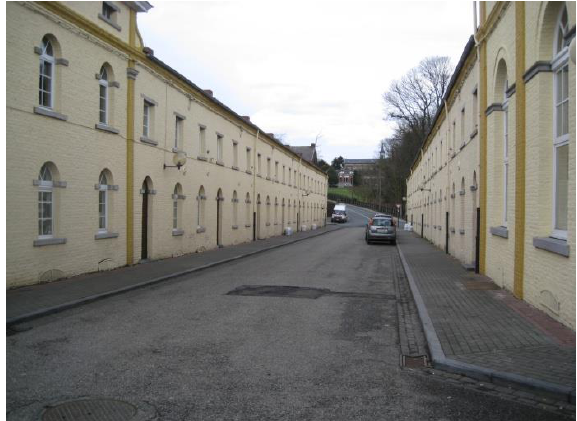
Figure 2: Workers quarters at Bois-du-Luc with the church St Barbara, the hospital, the school for the girls, the hospice, the houses for the engineer and employees, the park with its kiosk, the butcher and “glacière” and school for the boys and the library on the